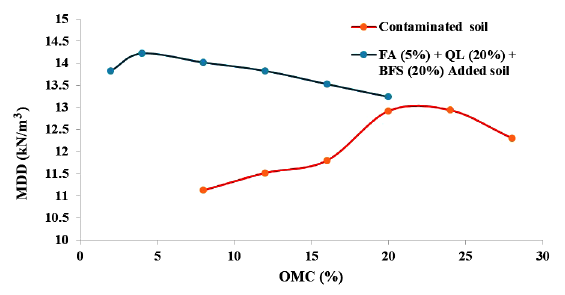
Figure 3. Comparison of compaction characteristics of contaminated and additives stabilized soil